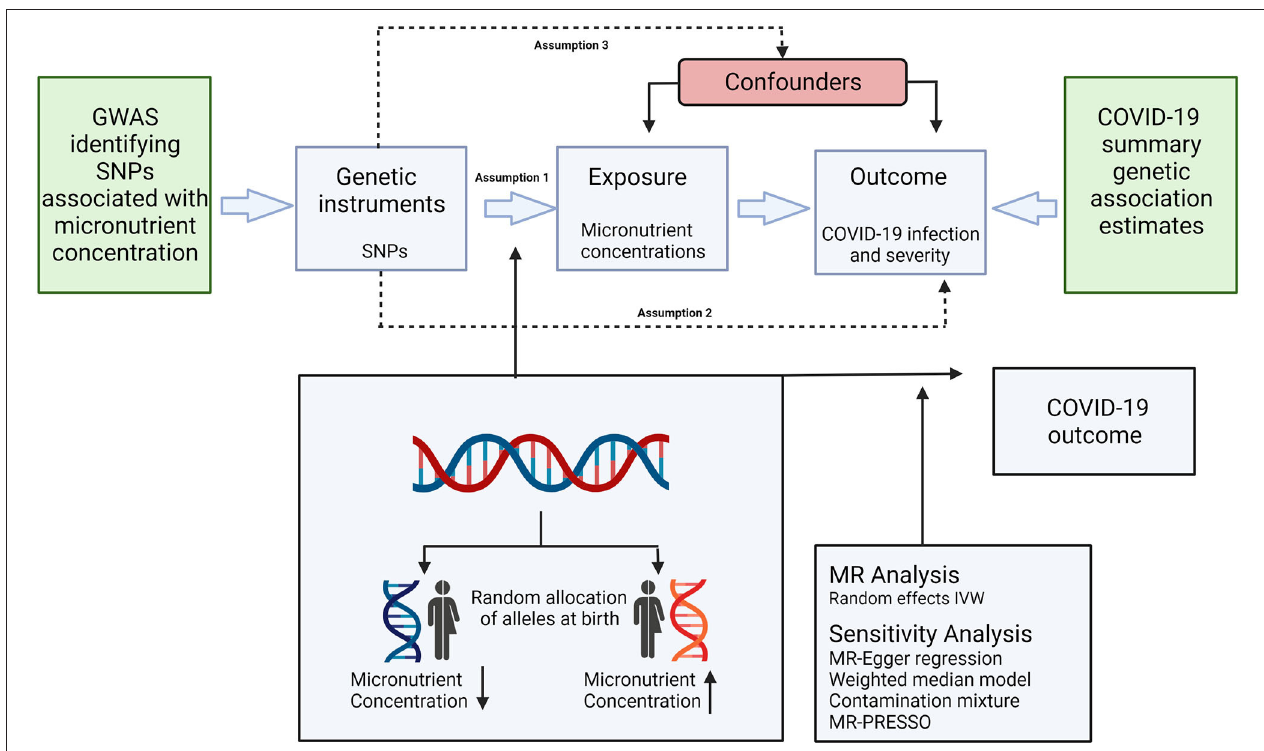
FIGURE 1 | Schematic representation of the Mendelian randomization assumptions and study design. Genetic instruments are selected based on their association with the concentration of a specific micronutrient (assumption 1), but do not directly impact the assessed outcomes (assumption 2), or any confounders of micronutrient concentrations and the assessed outcomes (assumption 3). IVW, inverse variance weighted; SNP, single nucleotide polymorphism; GWAS, genome-wide association study; MR, Mendelian randomization; MR-PRESSO, Mendelian randomization pleiotropy residual sum and